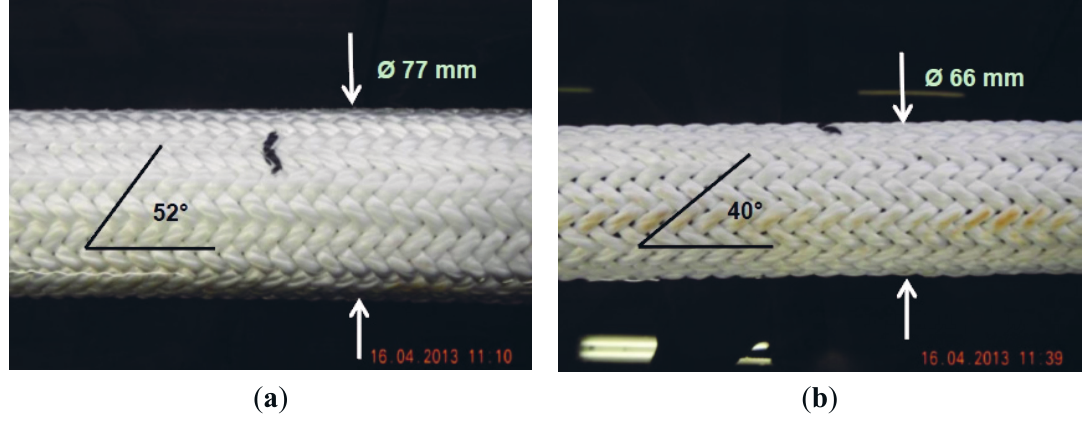
Figure 2. ( a ) P1-2 tether at zero extension; and ( b ) P1-2 tether at 30%